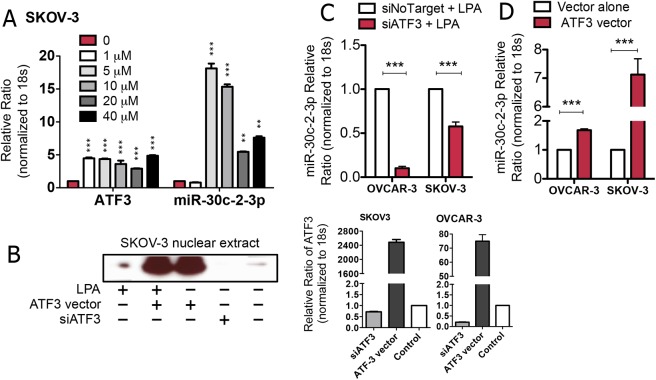
ATF3 modulates miR-30c-2-3p expression.(A) SKOV-3 cells were treated with increasing concentrations of lysophosphatidic acid (LPA) as indicated in μM for 1 h before measuring ATF3 mRNA and miR-30c-2-3p. (B) SKOV-3 cells were processed for immunoblotting to demonstrate the ability of the ATF3 expression vector and siATF3 to modulate ATF3 protein. Similarly, siATF3 enforced expression demonstrates the ability of the siRNA to suppress ATF3 mRNA transcription in SKOV-3 and OVCAR-3 cells using qRT-PCR normalized to microglobulin. (C) OVCAR-3 and SKOV-3 cells were transfected with siATF3 or an siNon-targeting control for 48 h prior to stimulation with LPA (5 μM, 1 h), followed by quantification of miR-30c-2-3p. (D) OVCAR-3 and SKOV-3 cells were transfected with an ATF3 expression vector or a control vector for 48 h prior to quantification of miR-30c-2-3p. ***p<0.001.